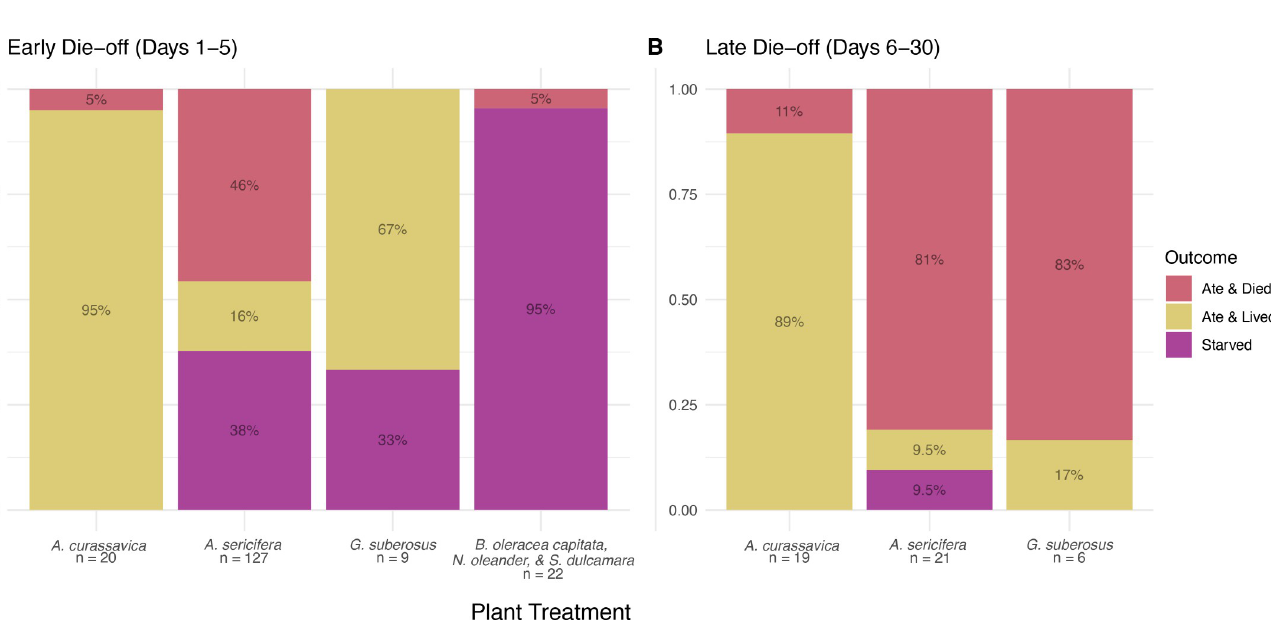
Fig 4. Outcomes of die-off events by plant treatment. (A) Outcomes of the early die-off. (B) Outcomes of the late die-off. Non-hosts are omitted because no larvae survived past day 5.